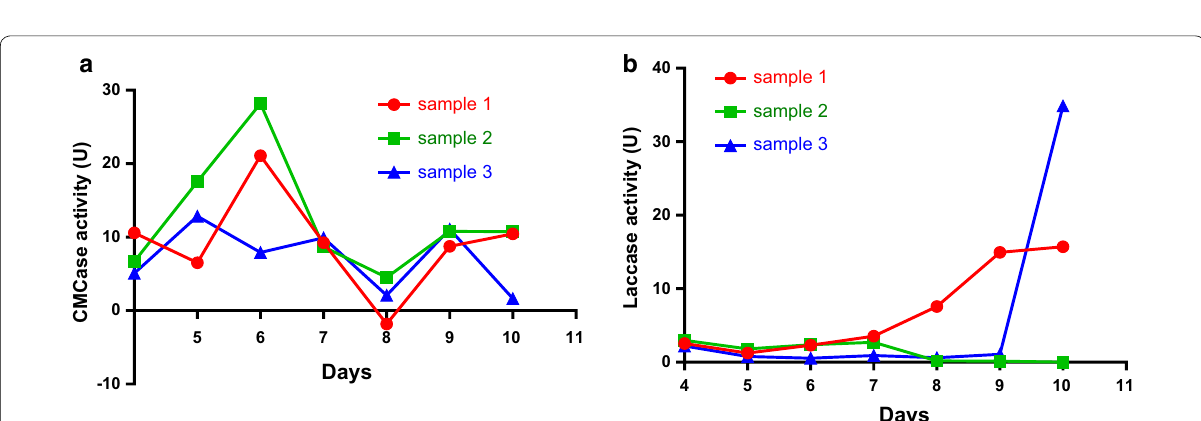
Fig. 5 a CMCase activity of P. ostreatus during liquid-state fermentation. b Laccase activity of P. ostreatus during liquid-state